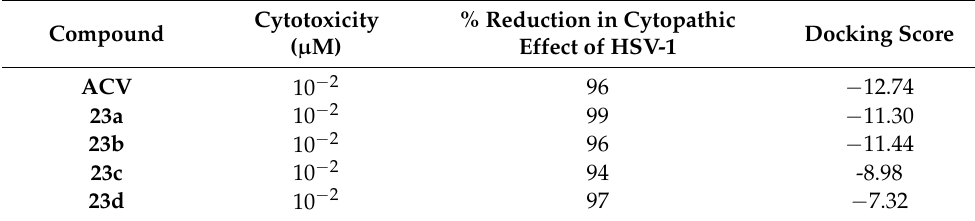
Table 4. Anti-HSV-1 activity and docking score of analogs 27a – d and Acyclovir [33]. Compound